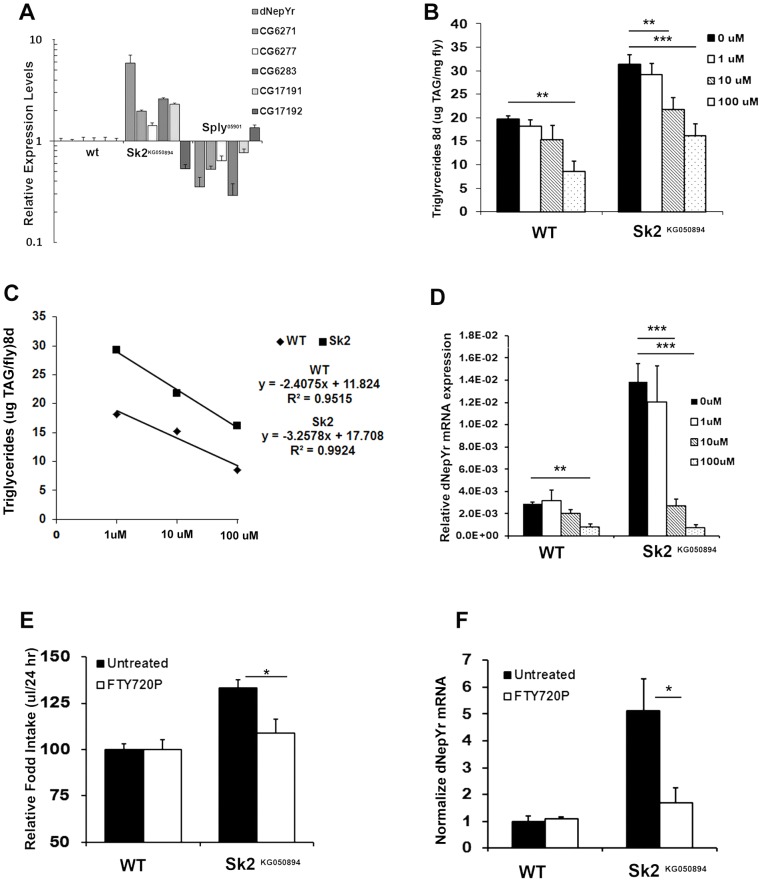
The ceramide:S1P rheostat's role in regulating dNepYr expression and caloric intake.(A) dNepYr expression is upregulated in Sk2KG6050894 and downregulated in Sply05901 mutants, with concurrent changes in overlapping cis-NAT's of pancreatic TAG lipase genes. Two day old Sk2KG6050894 flies and wt flies were administered 0 uM, 1 uM, 10 uM and 100 uM dRYamide (1∶1 dRYamide 1∶2) in solid food for 6 days, after which (B) TG levels, (C) rate of dose dependent TG decline, and (D) dNepYr mRNA levels were measured. Three to five day old Sk2KG6050894 flies were also administered S1P analogue FTY720P in the CAFE, after which (E) caloric intake (F) and dNepYr mRNA levels were measured. Error bars are represented by the S.E.M. p-values<*0.05, **<0.01, ***p<0.001.